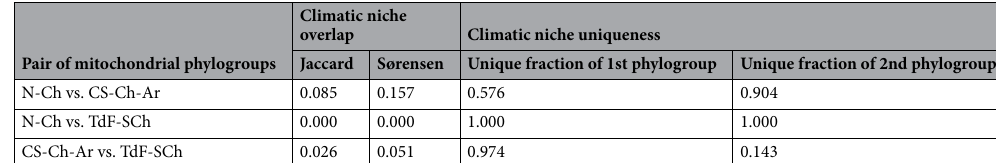
Table 5. Indexes of overlap and uniqueness of the climatic hypervolumes of the mitochondrial phylogroups of Abrothrix olivacea . The calculated overlap for the compared phylogroup pairs and their uniqueness are provided. Values can range from 0 to 1. The phylogroup from Mendoza, Argentina was not included in these analyzes.